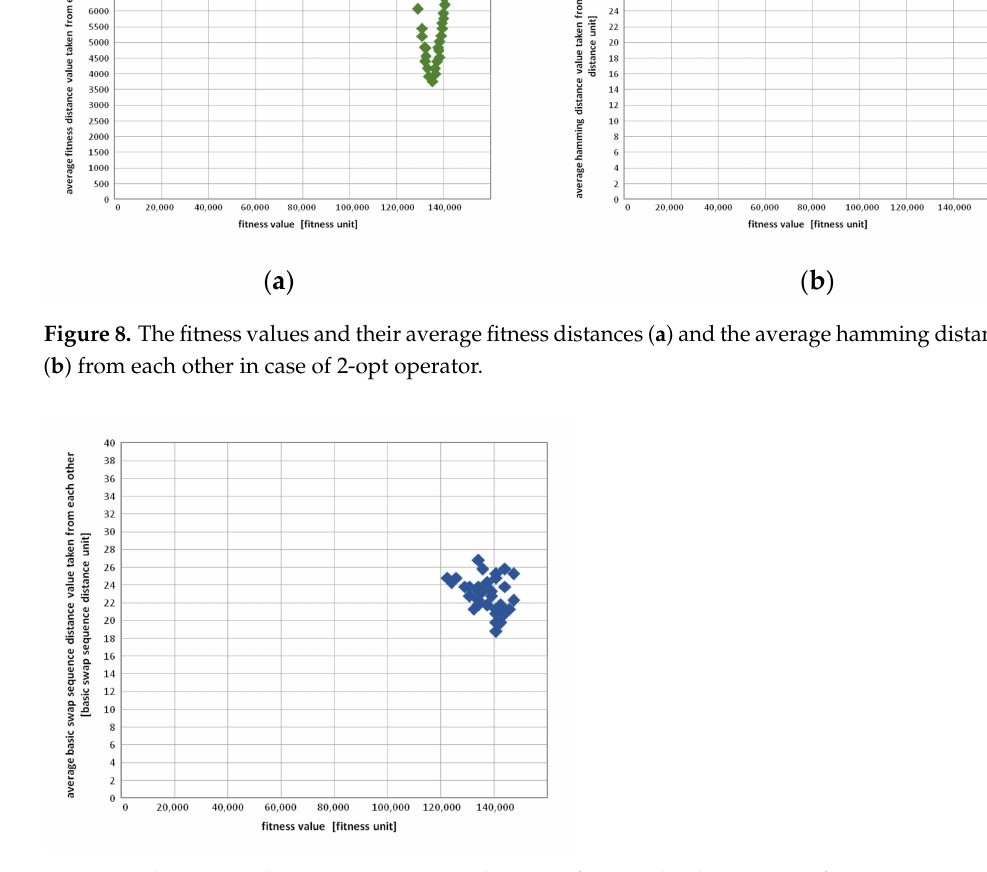
Figure 9. The average basic swap sequence distances from each other in case of 2-opt